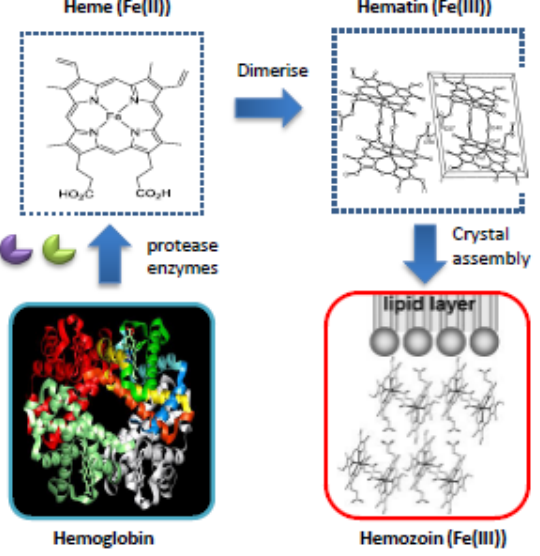
Figure 2. Detoxification of hemoglobin: toxic hematin (formed by hydrogen bonding of heme monomers) [12] is converted by the parasite to an insoluble non-toxic compound called hemozoin (it has recently been suggested that the propionate group of each Fe(III)PPIX molecule coordinates to the Fe(III) centre of its partner)